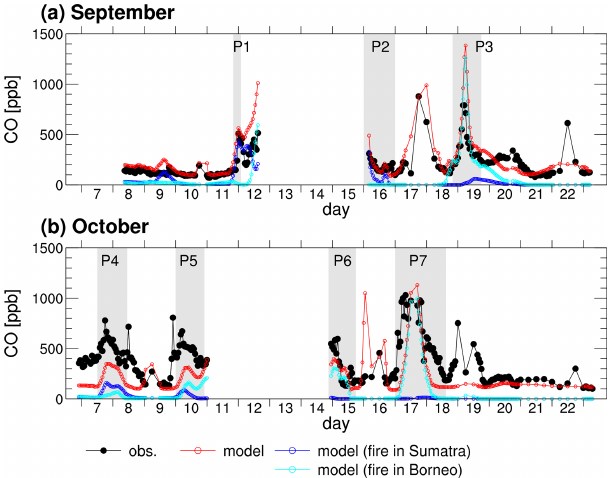
Figure 4. The same as Fig. 3, but for 15 August–15 November. The model simulations here show only fire contributions.